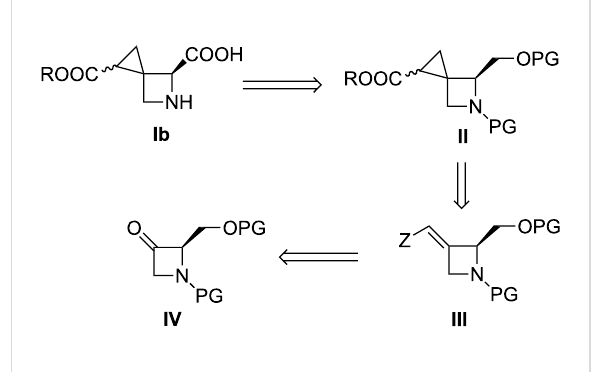
Scheme 1: Proposed synthetic plan for the preparation of compound of type Ib